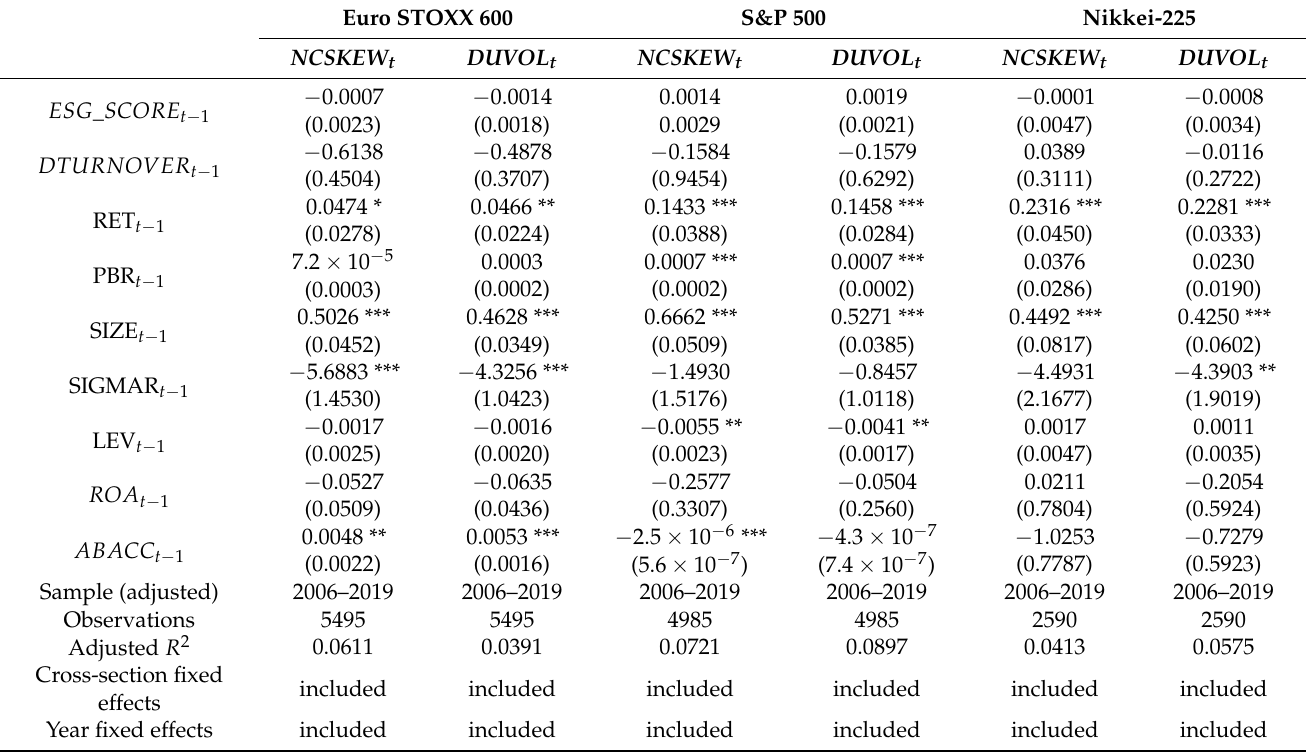
Table 5. Regression analysis on the effect of environmental, social, and governance disclosures on crash risk using static panel